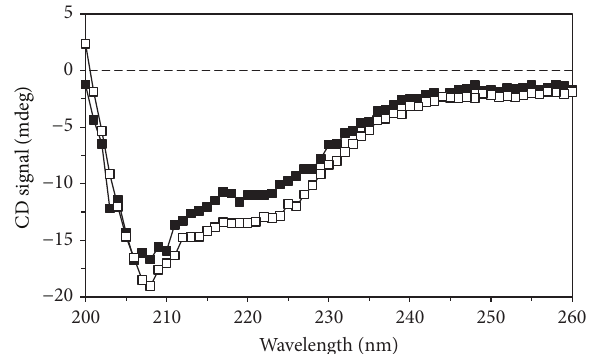
Figure 6: Absorbance spectra of sol-gel entrapped CPO immersed in 0.5 M potassium phosphate buffer with pH values of 6.0 (solid line),8.0(dashedline),and10.0(dottedline).Thesilicasol-gelsheets of 1mm thickness loaded with 1.6 mg/mL CPO were placed on the wall of plastic cuvette with a path length of